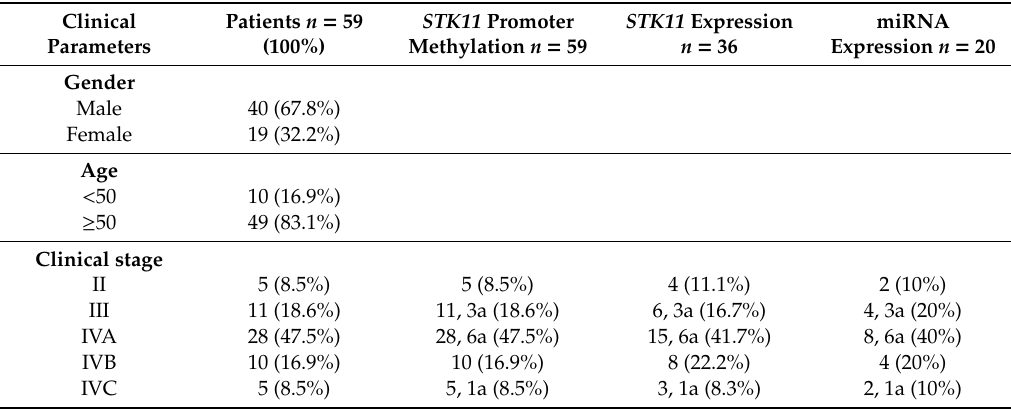
Table 2. Clinicopathologic characteristics of